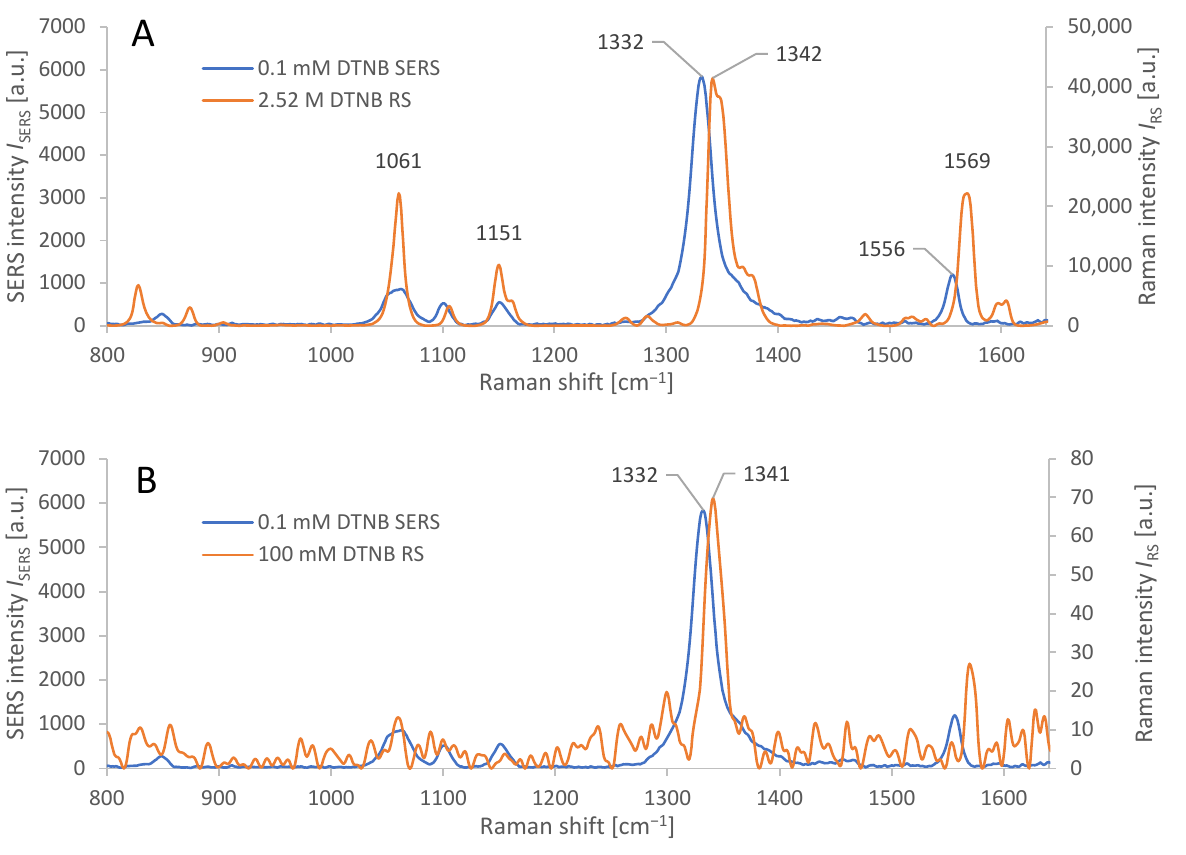
Figure 2. SEM image of the synthesized AuNRs placed on a thin carbon film. Taken at 30 kV, 50 pA with transmission detector in ( A ): Bright Field, ( B ): High Angle Annular Dark Field mode. Instru ‐ ment: Helios G4 (Courtesy of Thermo Fisher Scientific). Average dimensions: ( ≈ 90%): 40 ± 4 nm ×